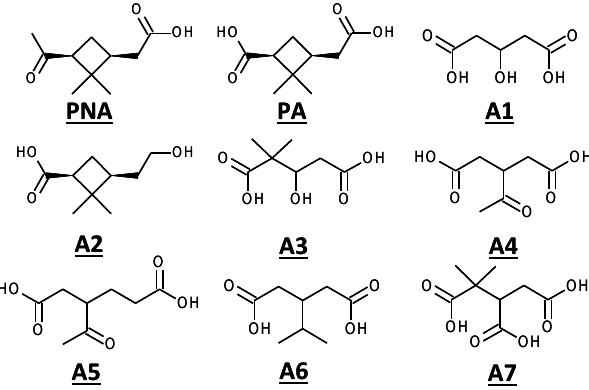
Fig. 2. α -pinene SOA markers consisting of 9 oxidation products: 3-hydroxyglutaric acid (A1), 3-(2-hydroxyethyl)-2,2-dimethylcyclobutane carboxylic acid (A2), 3-hydroxy-4,4-dimethylglutaric acid (A3), 3-acetylglutaric acid (A4), 3-acetyladipic acid (A5), and 3-isopropylglutaric acid (A6) and 3-methyl-1,2,3-butanetricarboxylic (A7), pinic acid (PA) and pinonic acid (PNA).